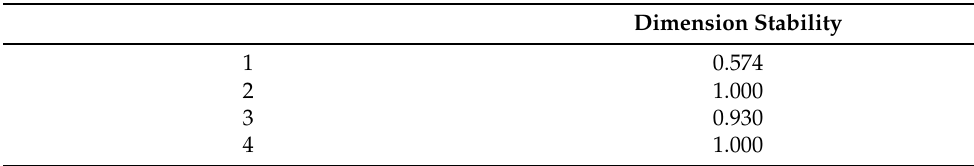
Table 3. Dimension stability of BAPQ items across all bootstrap replicate samples.